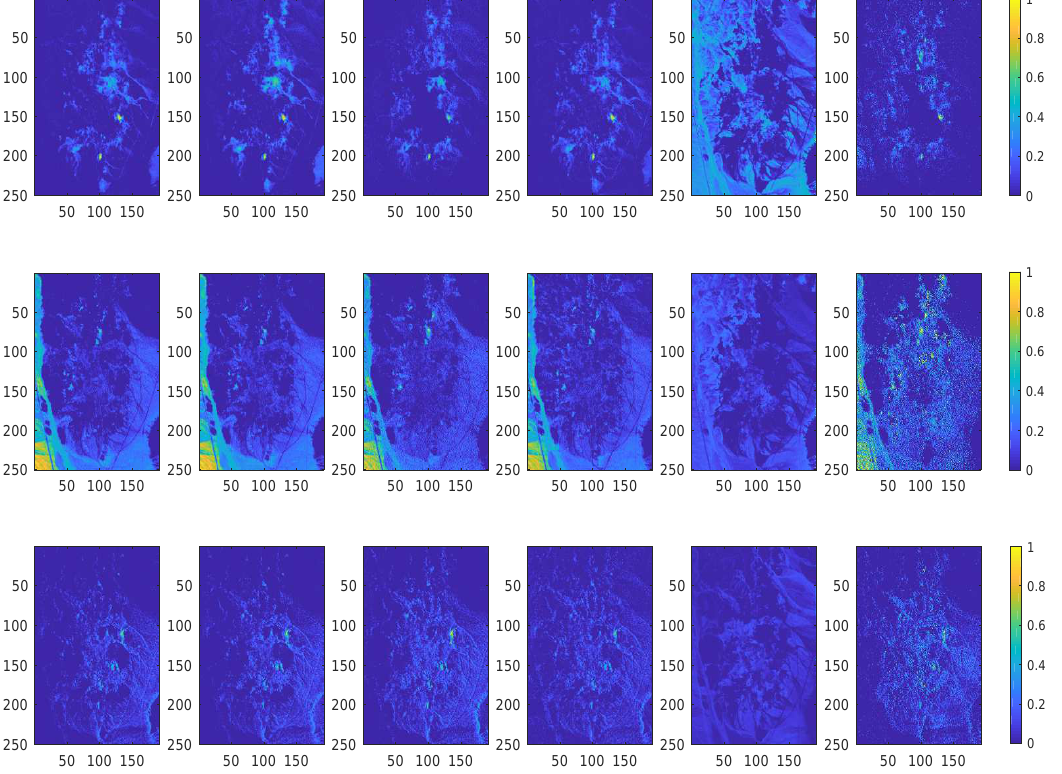
Figure 10. Abundances maps of selected materials of S 7 . From left to right: FCLS, SUnSAL, K-Hype ( G ), NDU ( G ), IIKNMF ( G ), Proposed ( G ). From top to bottom: the 1st endmember, the 6th endmember, the 10th